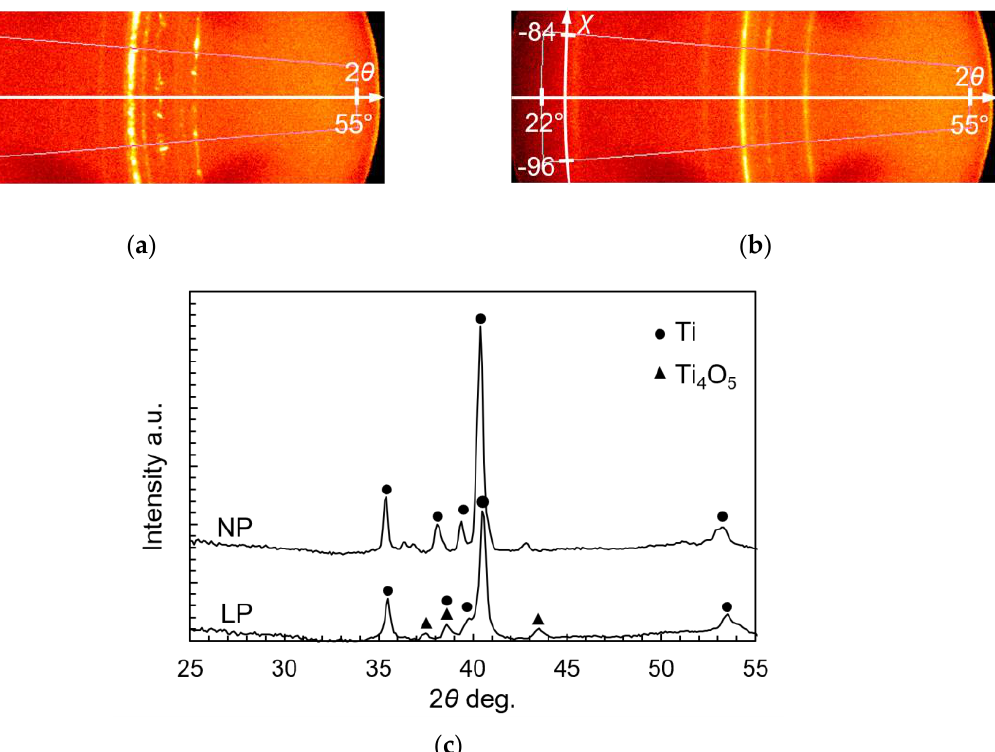
Figure 12. ( a ) 2D X-ray diffraction pattern of NP sample surface; ( b ) 2D X-ray diffraction pattern of LP sample surface; ( c ) 1D X-ray diffraction patterns from ( a , b ).